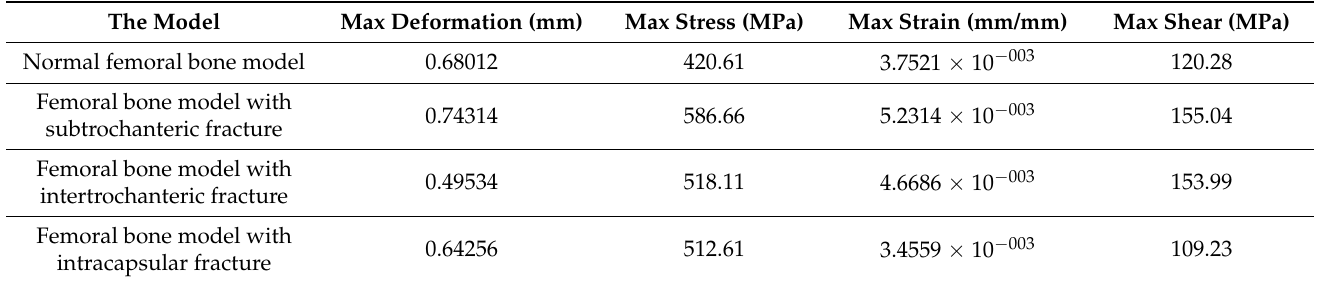
Table 13. Max deformation, strain, and shear in gait cycle